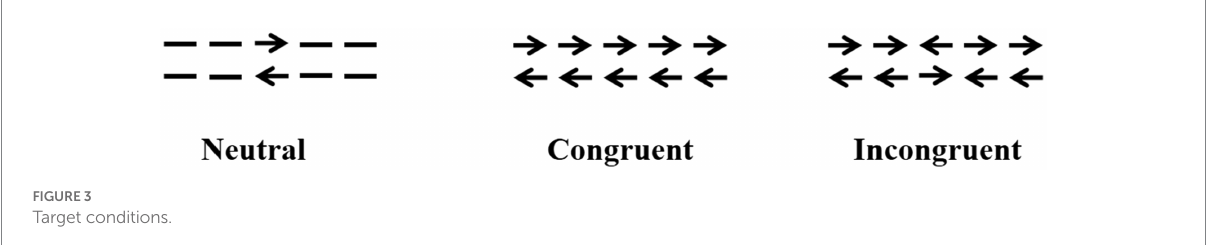
FIGURE 3 Target conditions.